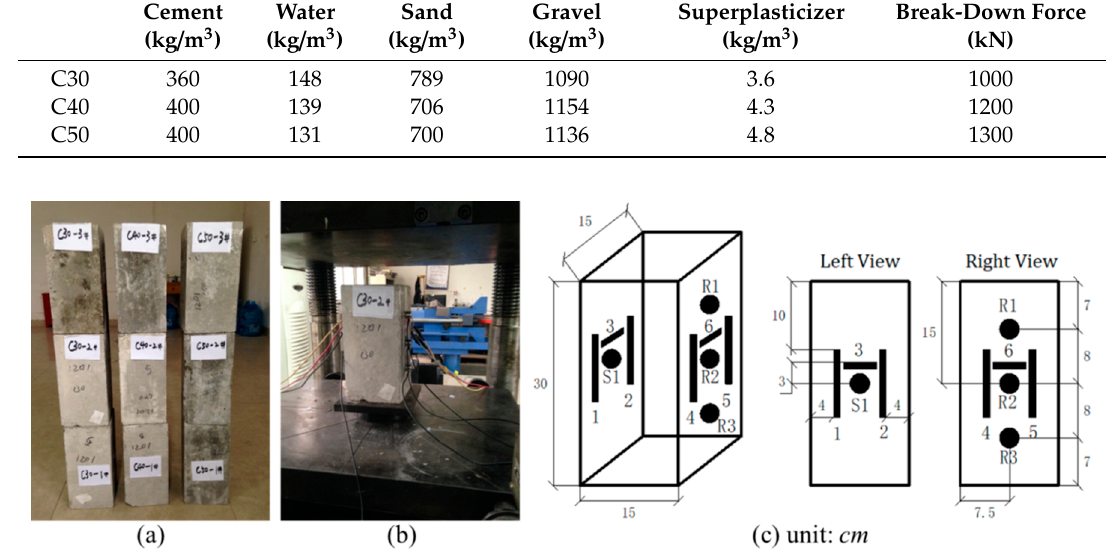
Figure 1. ( a ) Concrete samples, and ( b , c ) photographs and schematic layouts of the transducer (black solid circles) and gauge (black solid rectangles) locations.